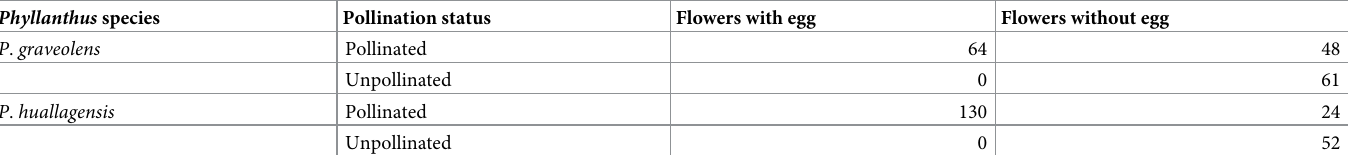
Table 2. Number of flowers with and without Epicephala moth eggs among pollinated and unpollinated flowers of Phyllanthus